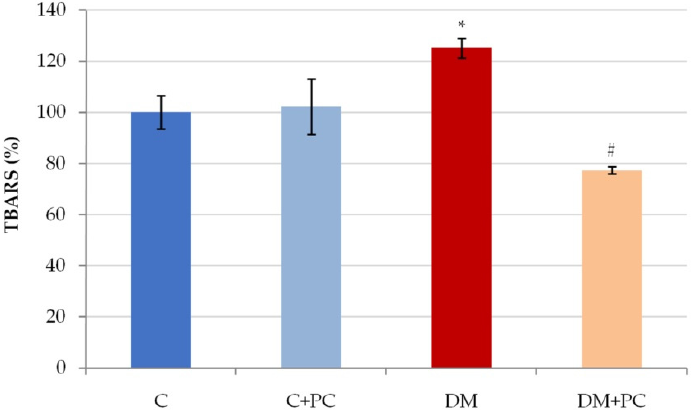
Figure 8. The content of TBARS in plasma of control rats, rats with experimental diabetes mellitus, with and without PC concentrate. Values of control rats are taken as 100%. C–normal untreated control animals; C + PC–animals that were per os administrated PC concentrate (daily dose of 45 mg/kg bw of polyphenolic complex for 14 days); DM–rats with experimental diabetes mellitus; DM + PC–animals with experimental diabetes mellitus that were per os administrated PC concentrate (daily dose of 45 mg/kg bw of polyphenolic complex for 14 days). *-significant difference compared to control ( p < 0.05); #-significant difference compared to diabetes mellitus ( p < 0.05).